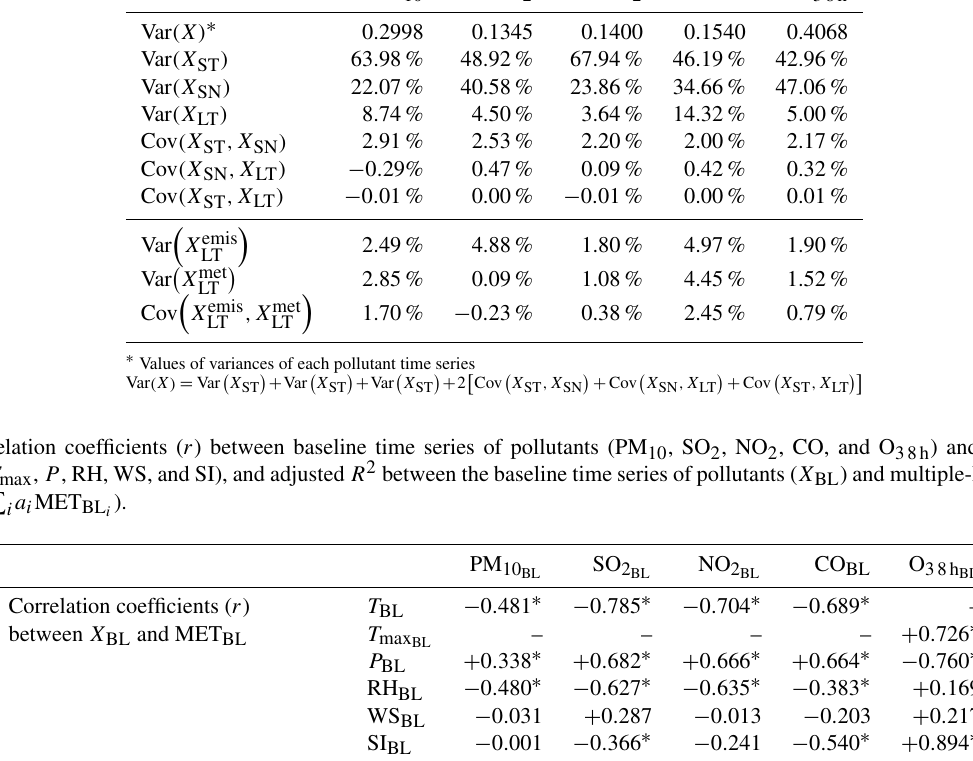
Table 1. Total variances (Var (X)) of log-scale times series for Seoul average concentrations of PM 10 , SO 2 , NO 2 , CO, and O 38h , and relative contributions (%) of variances of and covariances (Cov) among each component to Var (X) . Daily data for the period of July 2000 to June 2015 during which X LT data are available were used. PM 10 SO 2 NO 2 Var (X) ∗